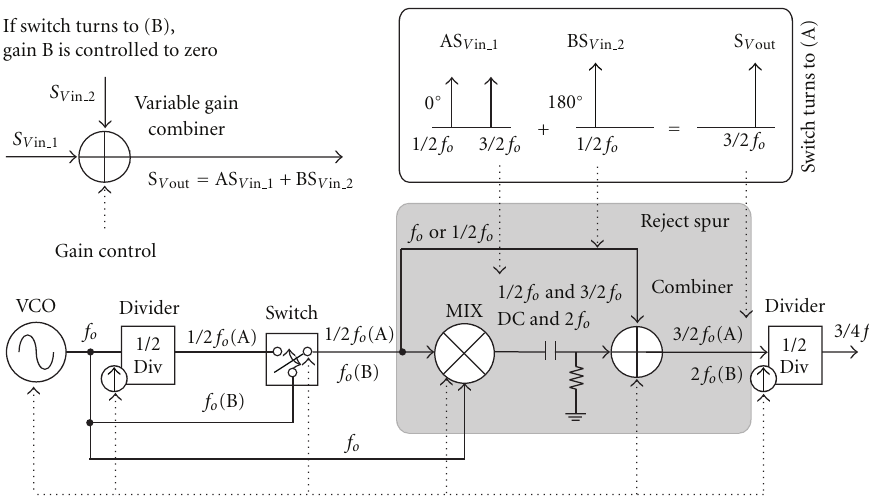
Figure 2: The proposed wideband VCO architecture.